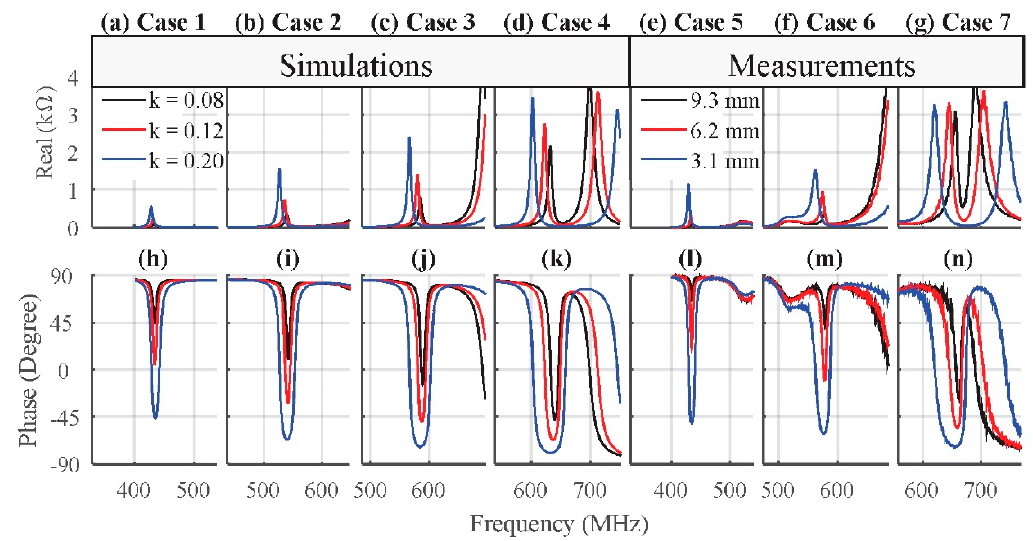
Figure 2. The raw data of four simulated cases and three test measurements that was used to compare readout methods. ( a – d ) The simulated real part of the impedance when the coupling coefficient was varied (k = 0.08, 0.12, 0.20) in Cases 1 to 4. ( e – g ) The test measurements of the real part of the impedance when the reading distance was varied (9.3 mm, 6.2 mm, 3.1 mm) in Cases 5 to 7. ( h – k ) The corresponding simulated phase angle and the measured phase angle ( l – n